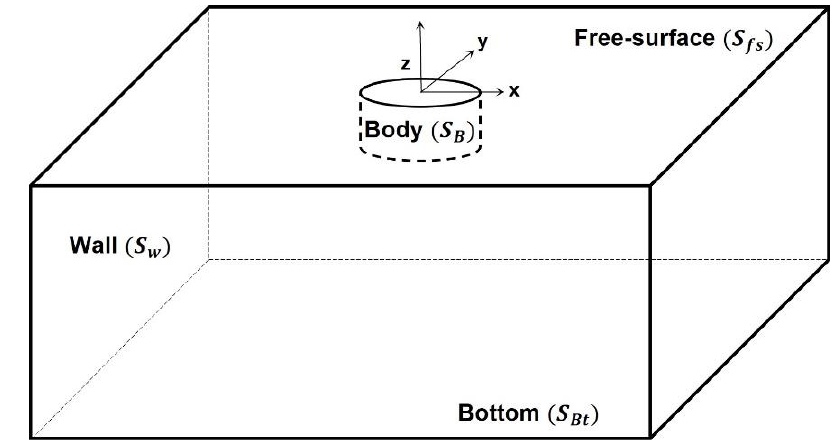
Figure 1. Computational fluid domain of a 3D FR-NWT.